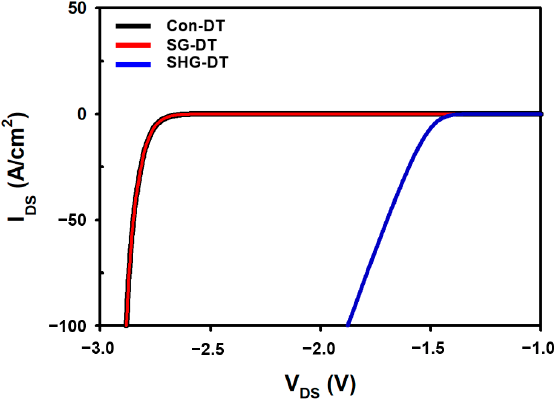
Figure 5. The forward conduction state characteristics of body diodes of Con-DTMOS, SG-DTMOS, and SHG-DMOS.